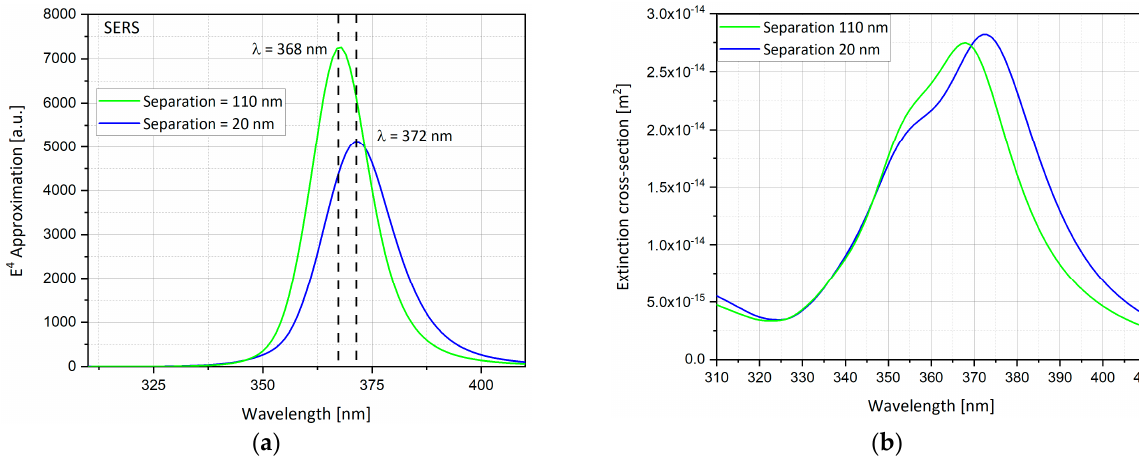
Figure 24. Simulation of four separated hemi-spheroid particles (separation = 20 nm, 110 nm). The width of physical geometry W = 250 nm. ( a ) E 4 approximation; ( b ) extinction cross-section.